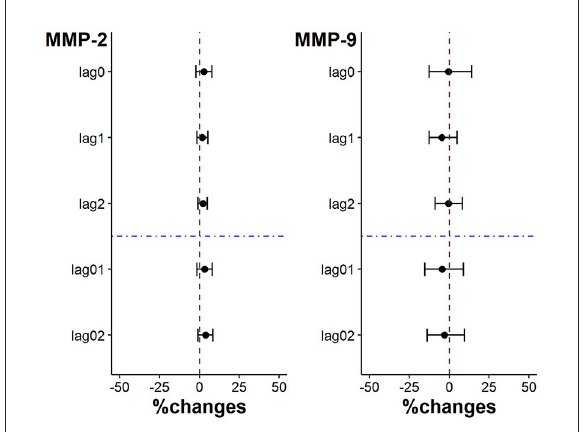
FIGURE4 Percent changes in plaque stability indicators associated with an IQR decrease in PM 2.5